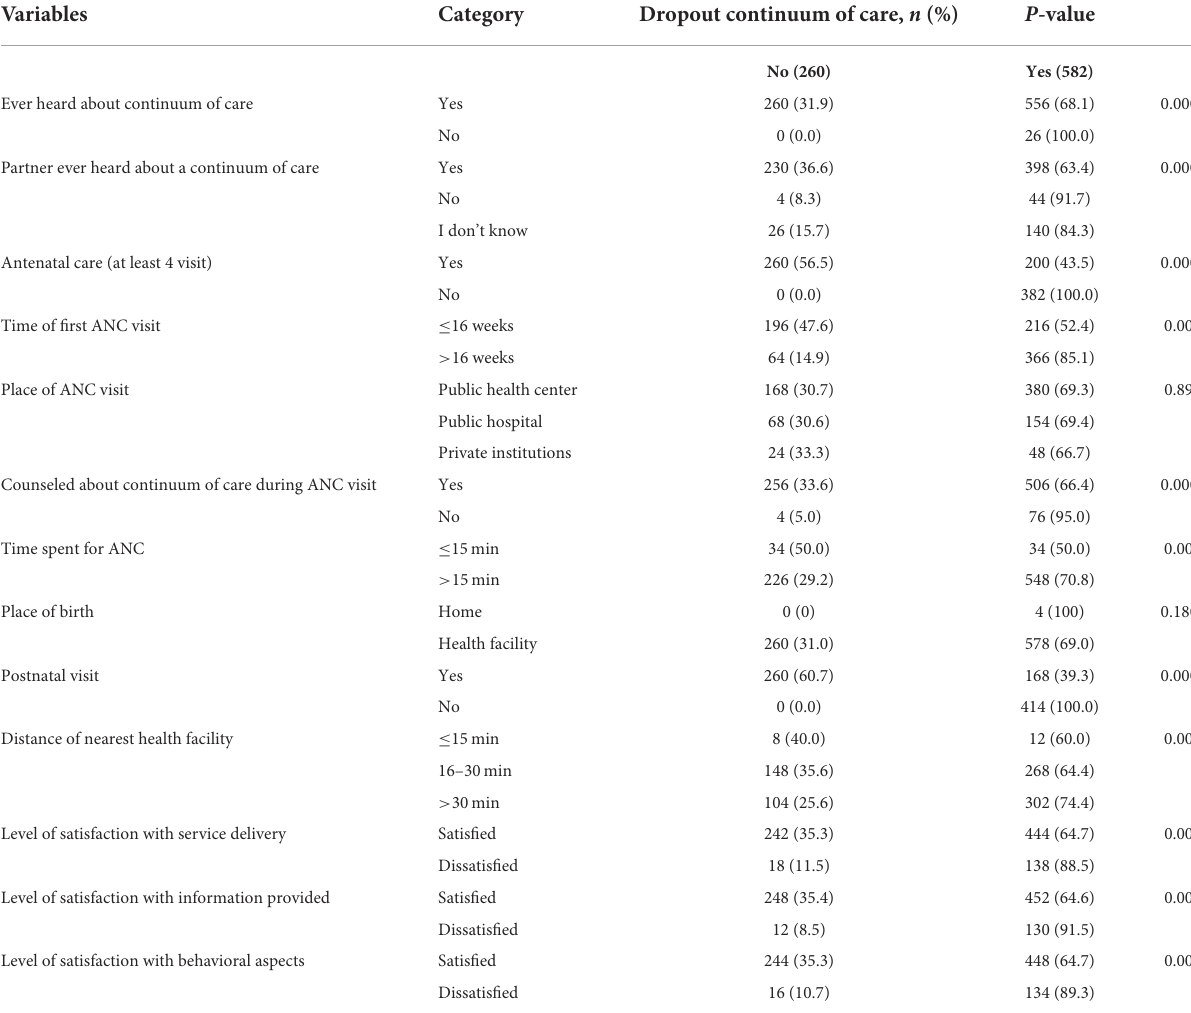
TABLE 3 Maternal healthcare service utilization by dropout from continuum of care in Debre Berhan town, northeast Ethiopia.